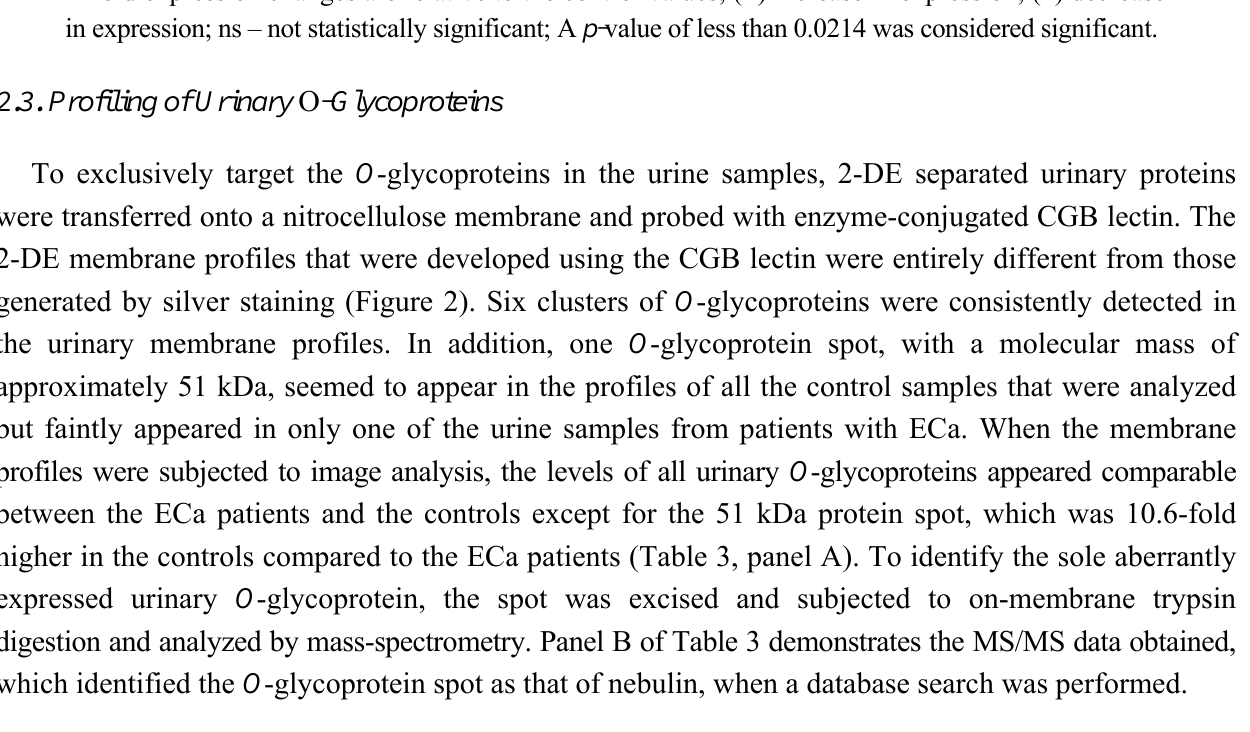
Table 3. Relative expression (A) and identification of nebulin